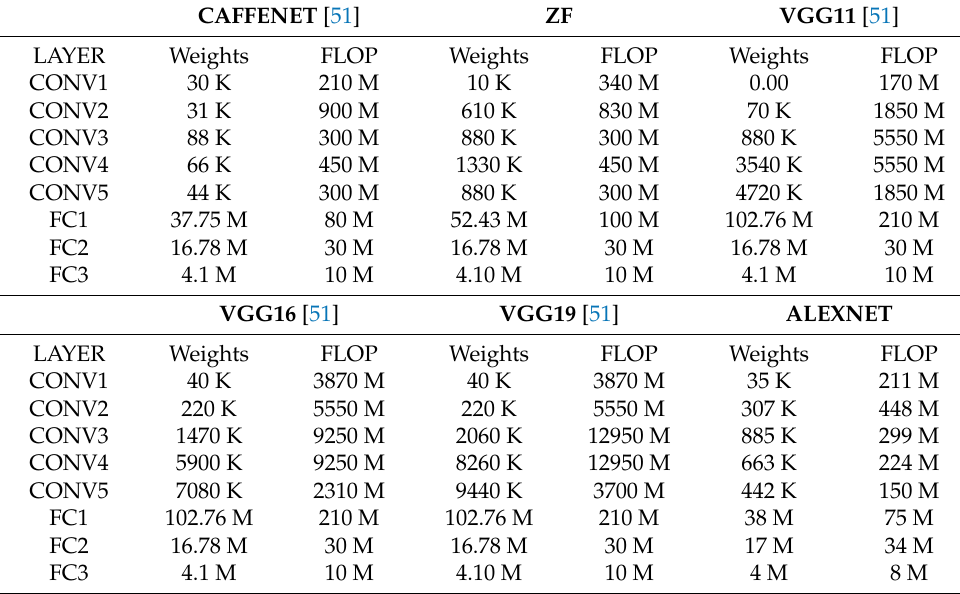
Table 10. Parameters for popular CNN models.